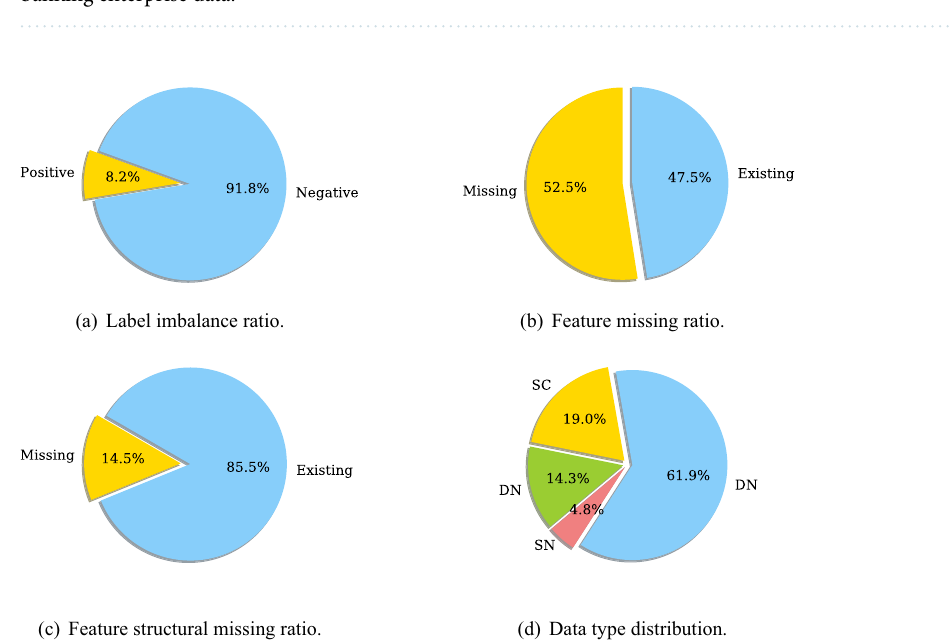
Figure 9. The weighted accuracy of classification by baselines versus Table2Vec-based classification on the banking enterprise data.